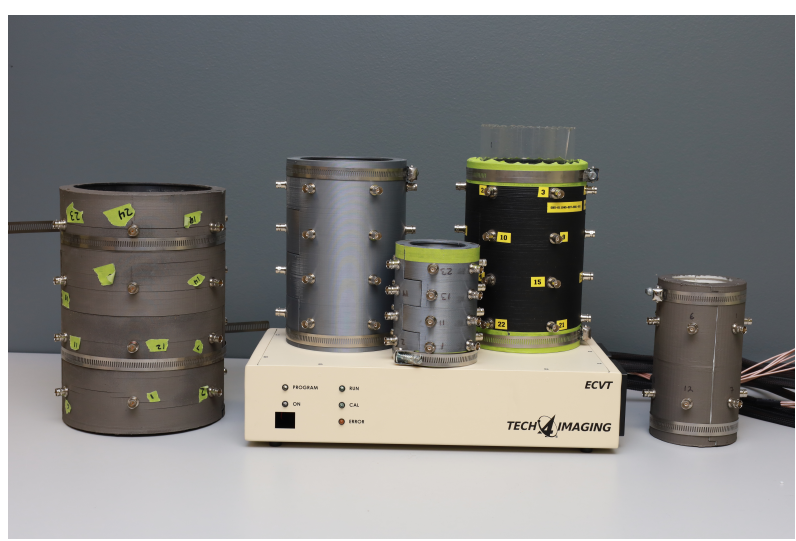
Figure 2. Data acquisition system and several cylindrical ECVT sensors of various sizes and with different numbers of electrode